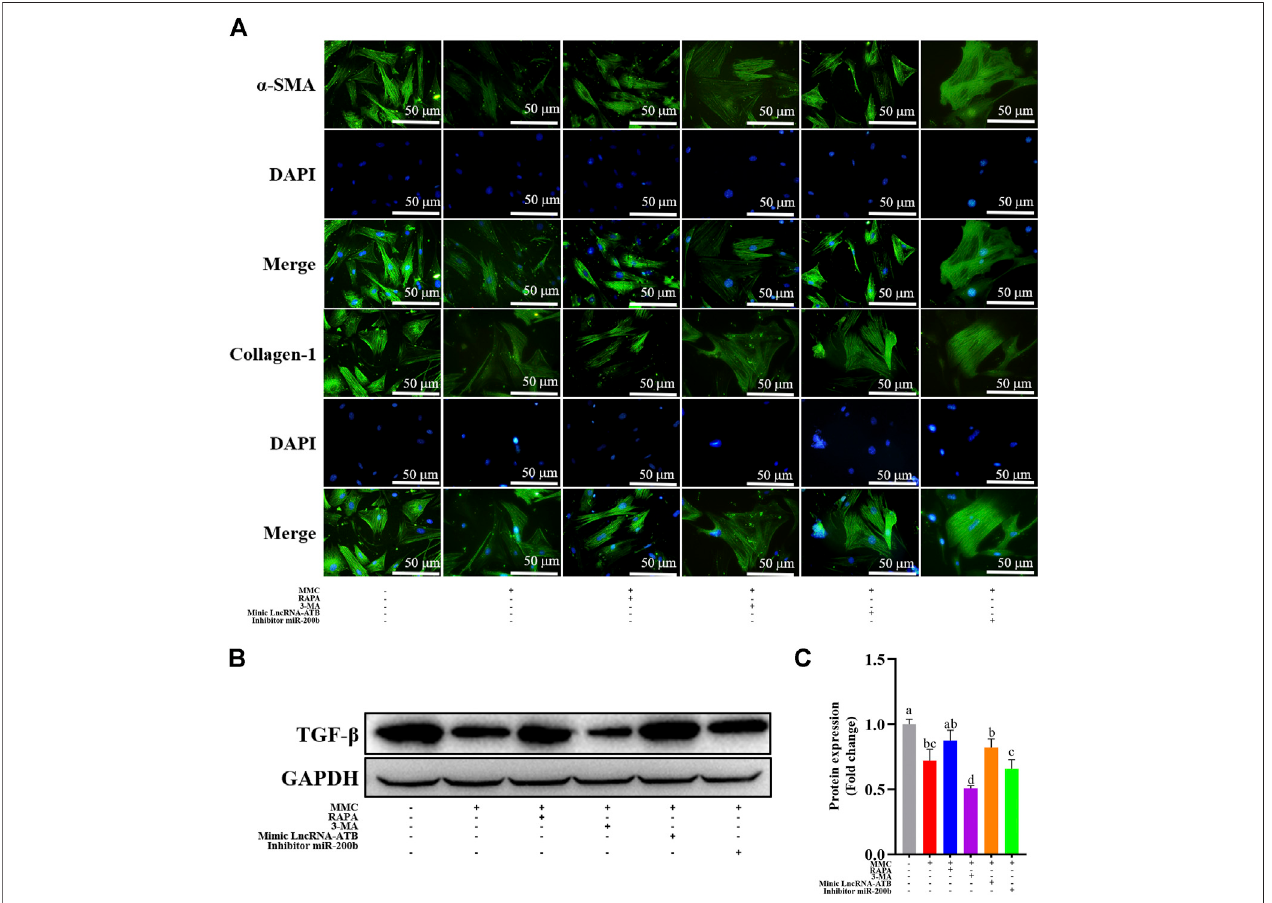
FIGURE 5 | MMC treatment combined with autophagy agonist or antagonist, or lncRNA-ATB mimic or miR-200b inhibitor regulated fi brotic marker proteins. (A) Expression of α -SMA and collagen-1 were shown by immuno fl uorescence after treatment with or without MMC, MMC + RAPA, MMC+3-MA, MMC + lncRNA-ATB mimic or MMC + miR-200b inhibitor. (B) Western blotting was used to determine the expression levels of TGF- β treated with or without MMC, MMC + RAPA, MMC+3- MA, MMC + lncRNA-ATB mimic or MMC + miR-200b inhibitor. (C) Relative protein expression level of TGF- β was shown compared with each other. Different letters on the bar chart meant signi fi cant difference.